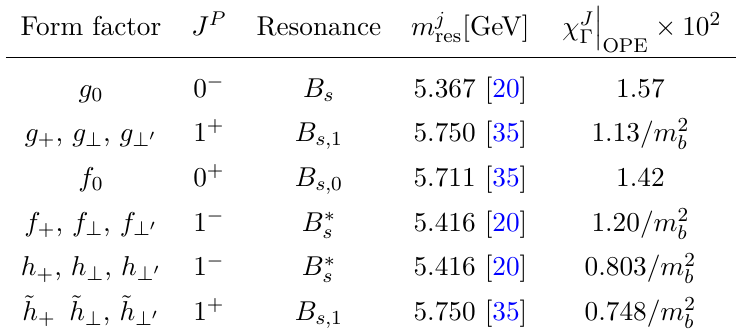
Table 1 . Parameters for the form factor expansion. The reference value for the b -quark mass is m b = 4 . 2